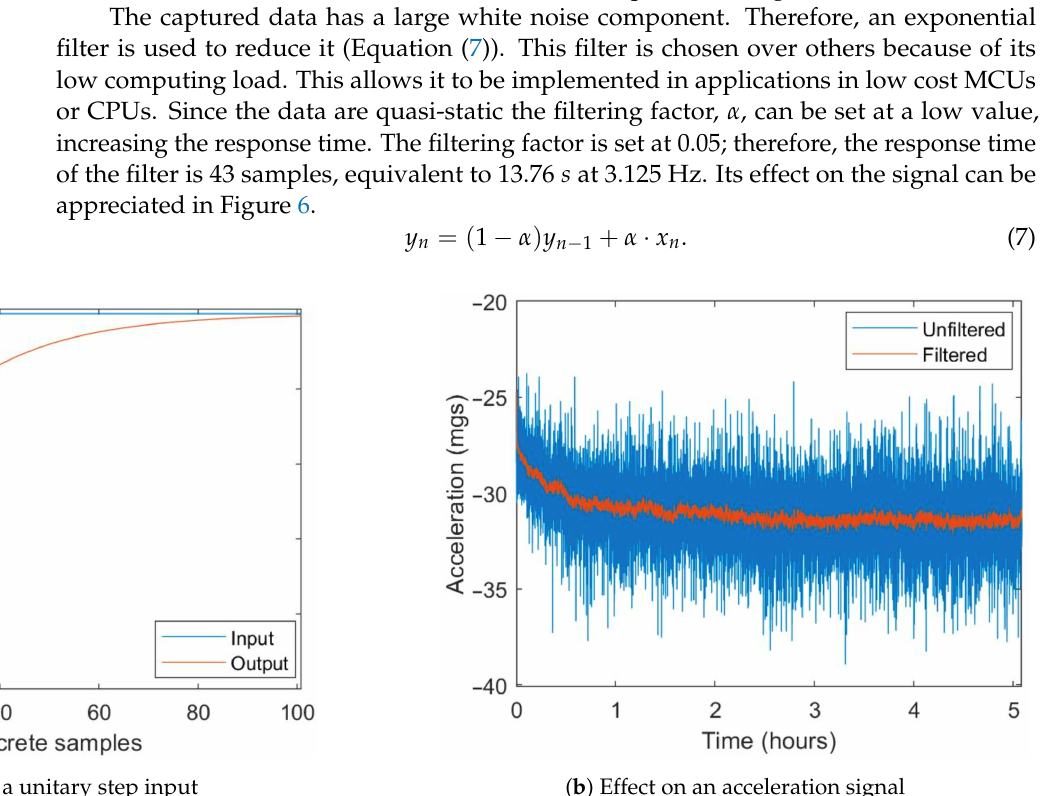
Figure 6. Exponential filter